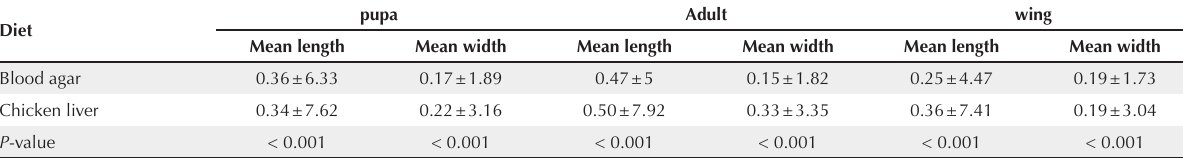
Table 2. Analysis of the Results of the Length and Width Measurements (millimeter) of L. sericata Using t -test